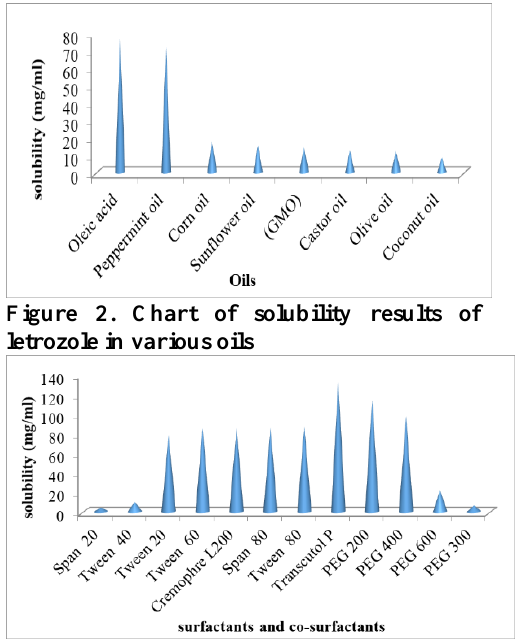
Figure 3. Letrozole solubility in different surfactants and co-surfactants